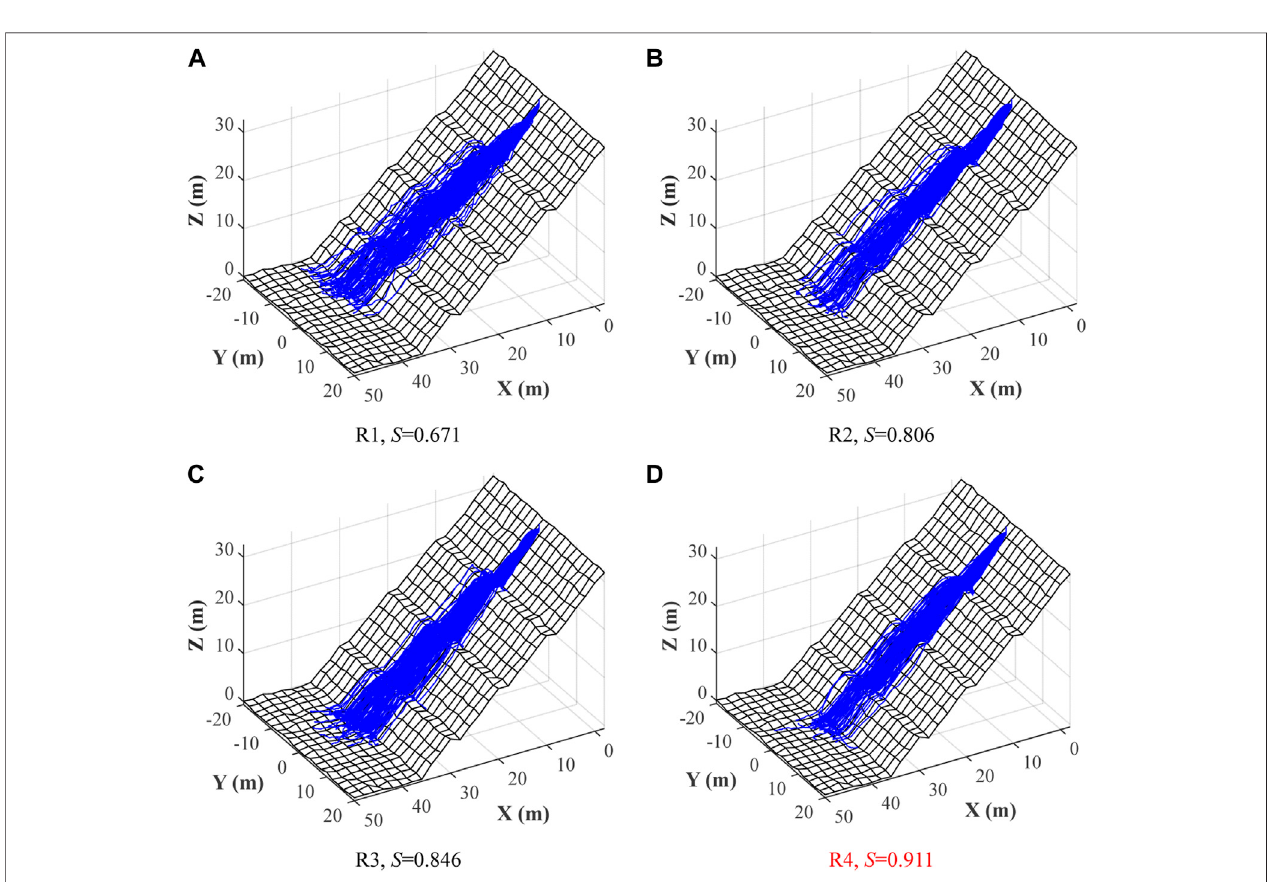
FIGURE 9 | Maps showing spatial distribution of trajectories vs. sphericities on S2 ( R (cid:1) 1/4). (A) R1, S (cid:1) 0.671. (B) R2, S (cid:1) 0.806. (C) R3, S (cid:1) 0.846. (D) R4, S (cid:1) 0.911.